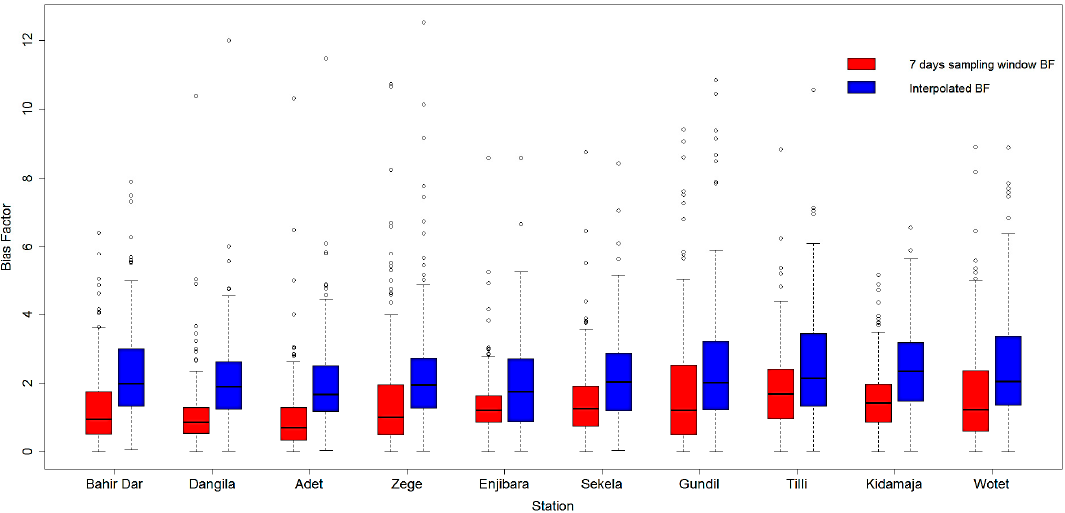
Figure 6. Whisker plot showing comparison of BF’s obtained from: (i) 7 day sampling window (red fill) and (ii) IDW interpolation (blue fill). The horizontal line inside the box depicts the median, the top and bottom boundary of the box depicts the upper and lower quartile (25% and 75%, respectively) while the whisker shows the maximum and minimum values excluding outliers. Outliers are shown by individual points (greater than 1.5 times the upper quartile). The x -axis denotes the rain gauge stations. The analysis period is from January 2003 to December